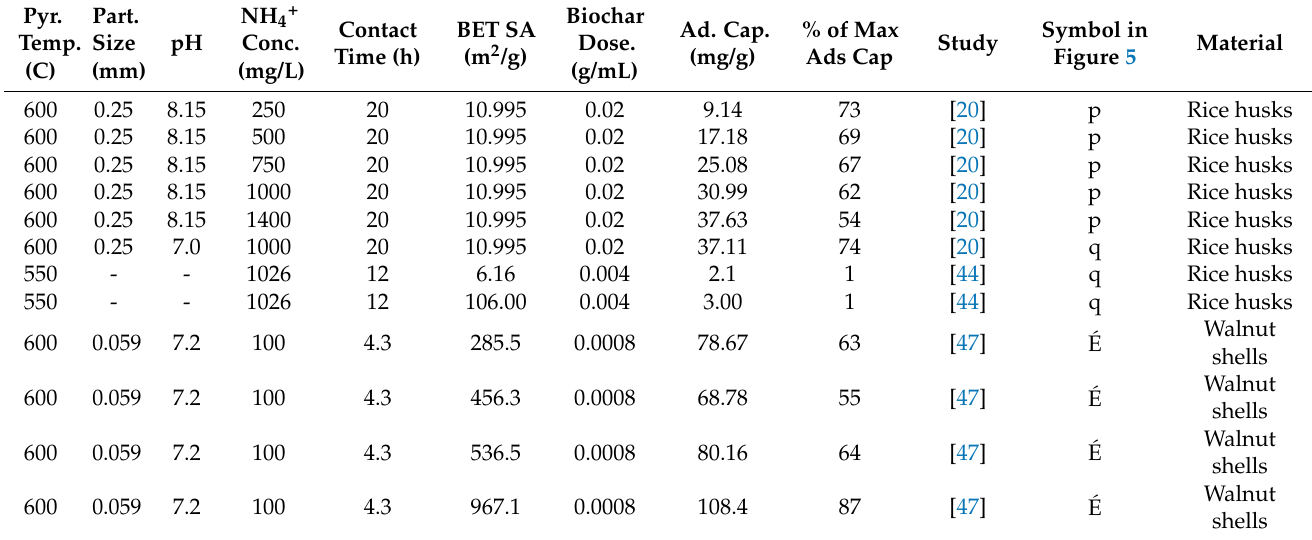
Table 3. Agricultural waste experiment examples of trends from